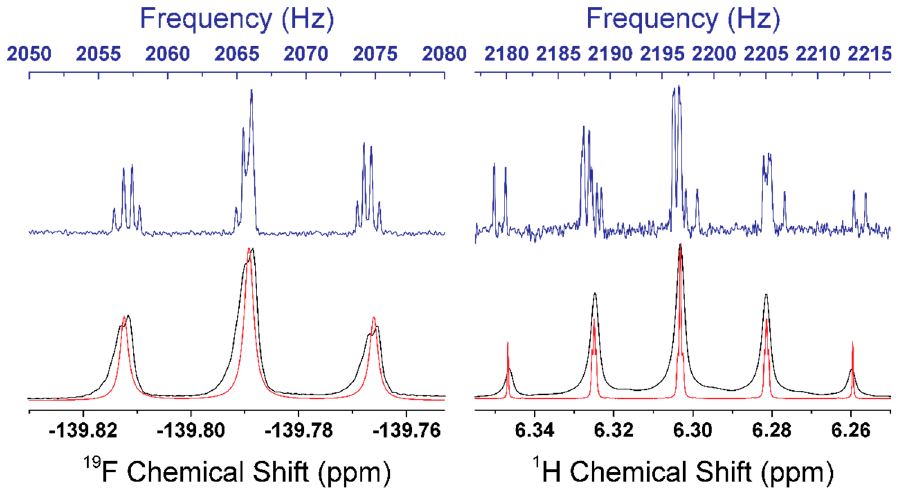
Figure 12. The experimental high field (9.4 T) NMR spectrum (black) and JCS (blue) of 1,2,4,5-tetrafluorobenzene for both the 19 F (left) and 1 H (right) portions of the spectra. The high field spectrum was simulated (red) using the same parameters obtained from the experimental JCS. Multiple peaks in the simulated subspectra in the 1 H region indicated that the experimental subspectra information was likely hidden at this field due to line broadening. The 19 F high field simulated spectrum showed no subspectra structure. Clearly, the JCS provides more detailed subspectra than either high field spectrum.